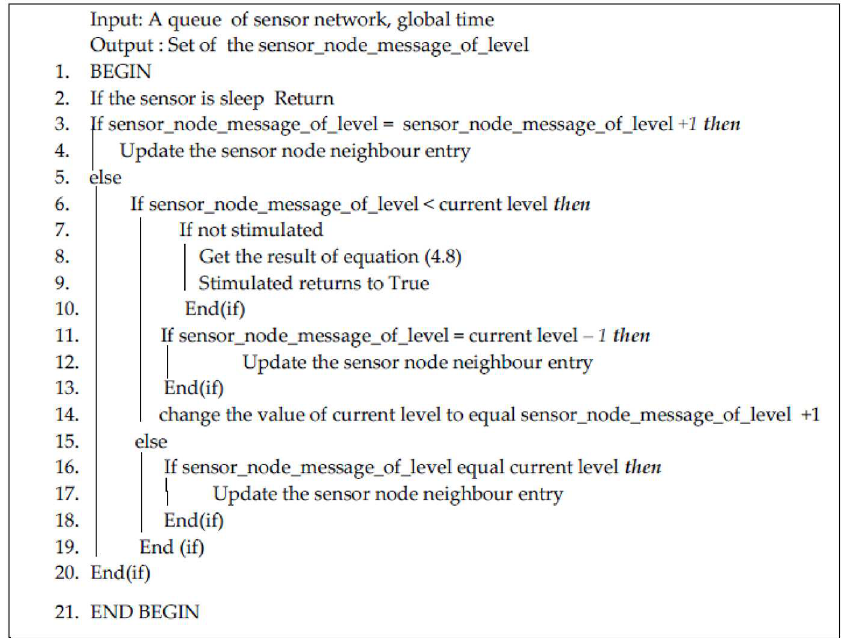
Fig 5. Pseudocode of level adjustment in the TWPCO scheme.